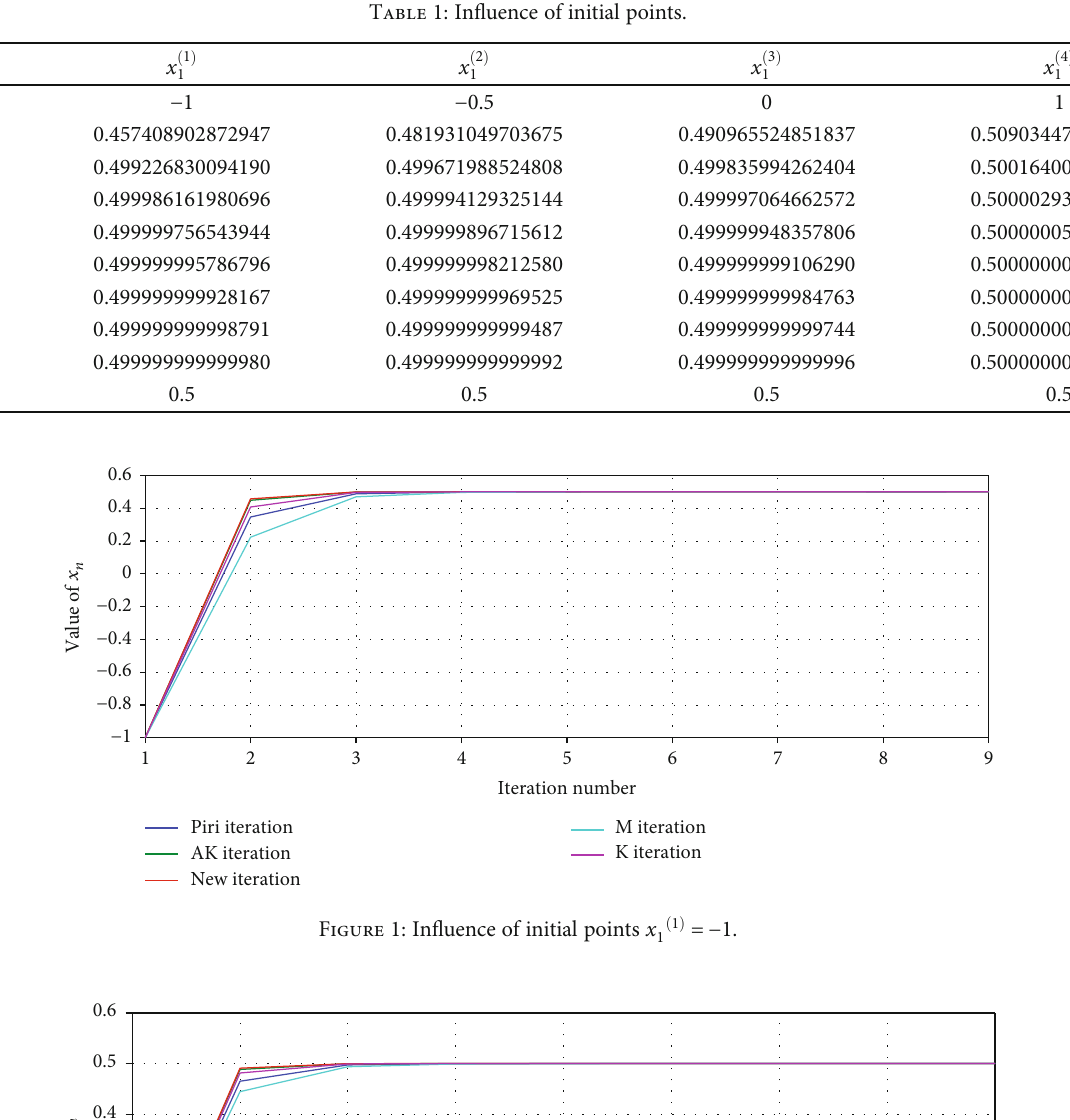
Figure 1: In fl uence of initial points x